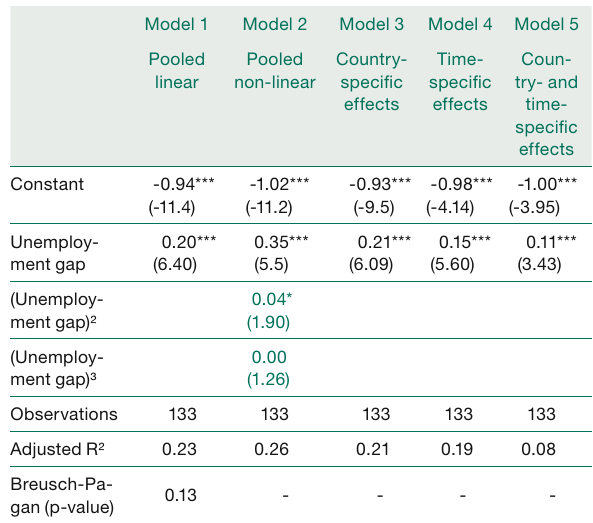
Estimation results: EMU Phillips curve